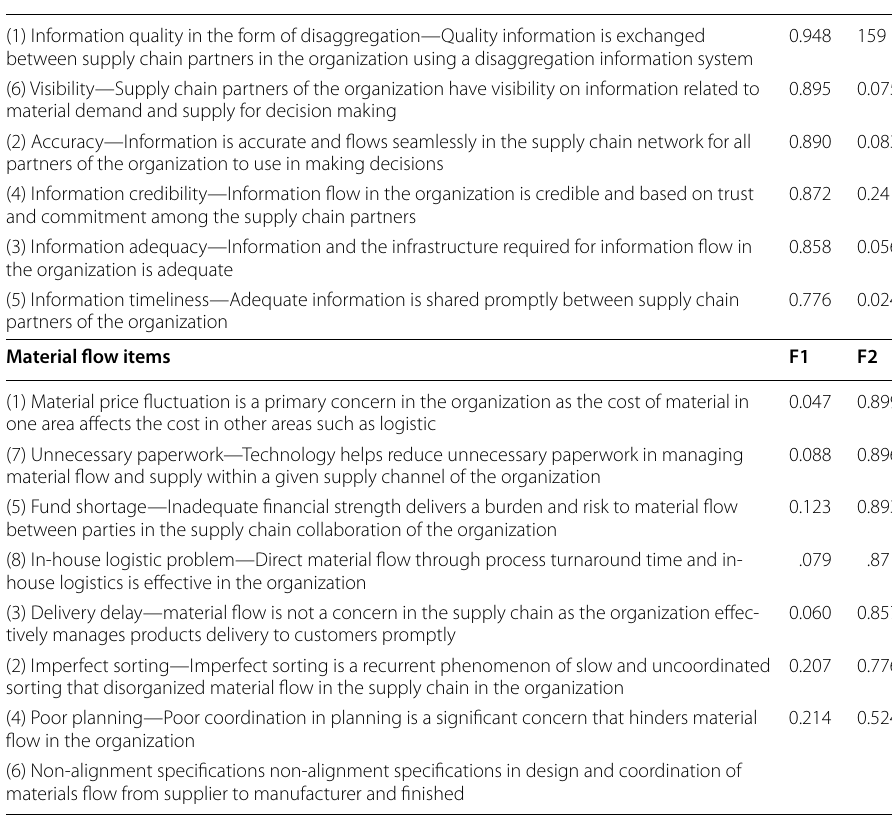
Table 2 Varimax rotation Information flow items